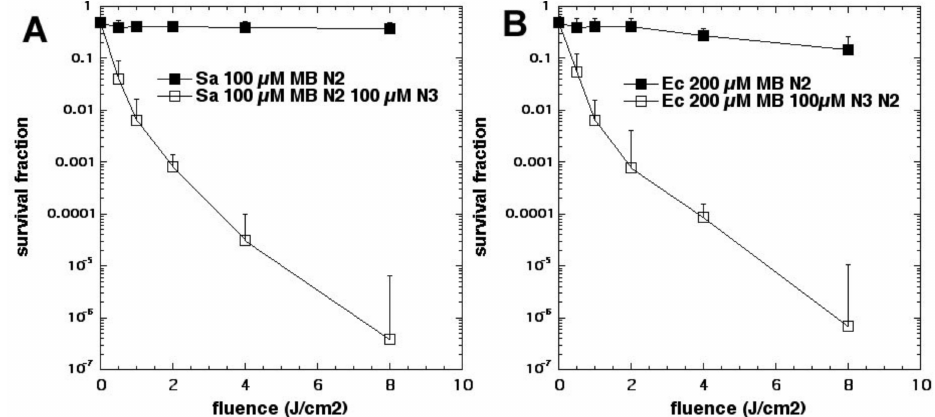
Figure 4. Oxygen-independent (under nitrogen) MB photoinactivation by addition of sodium azide. ( A ) S. aureus ; ( B ) E. coli. Figure adapted from data contained in